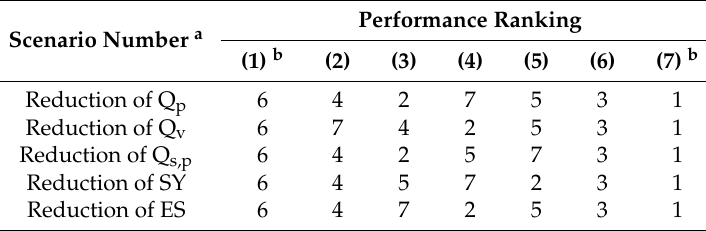
Table 7. Performance ranking in flood and sediment control among di ff erent